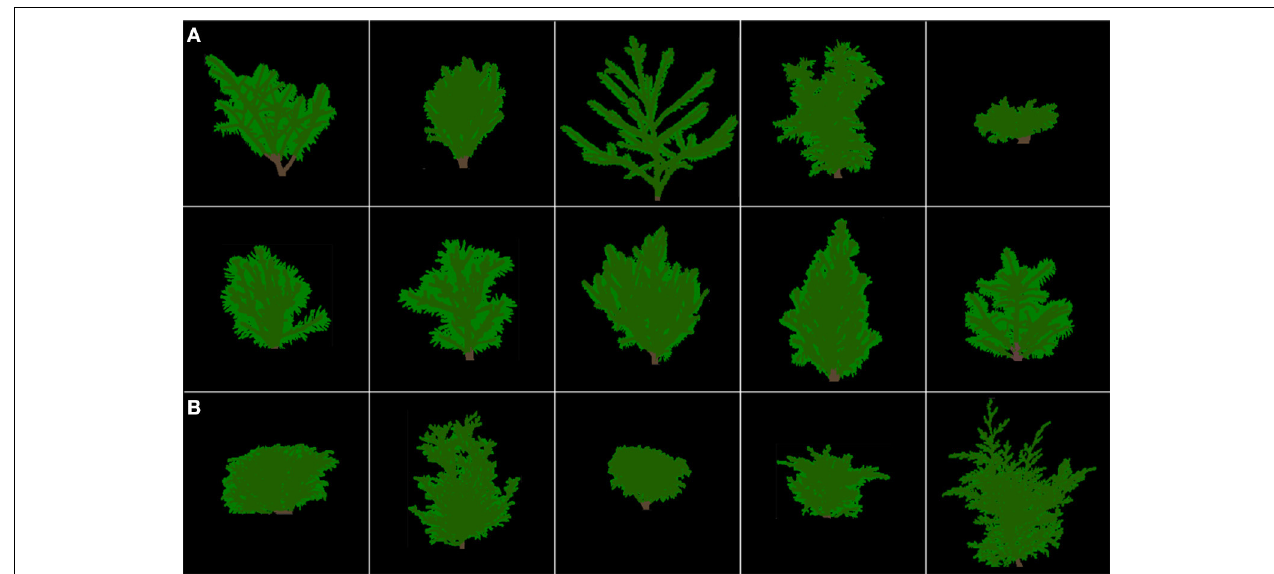
FIGURE 5 | False-colored 3-D renderings of the complete crowns (branches in brown, leaves in green) for the 15miniature conifers of Figure 4, in same order and size representation. (A) with needlelike leaves (first two rows) and (B) with scalelike leaves (third